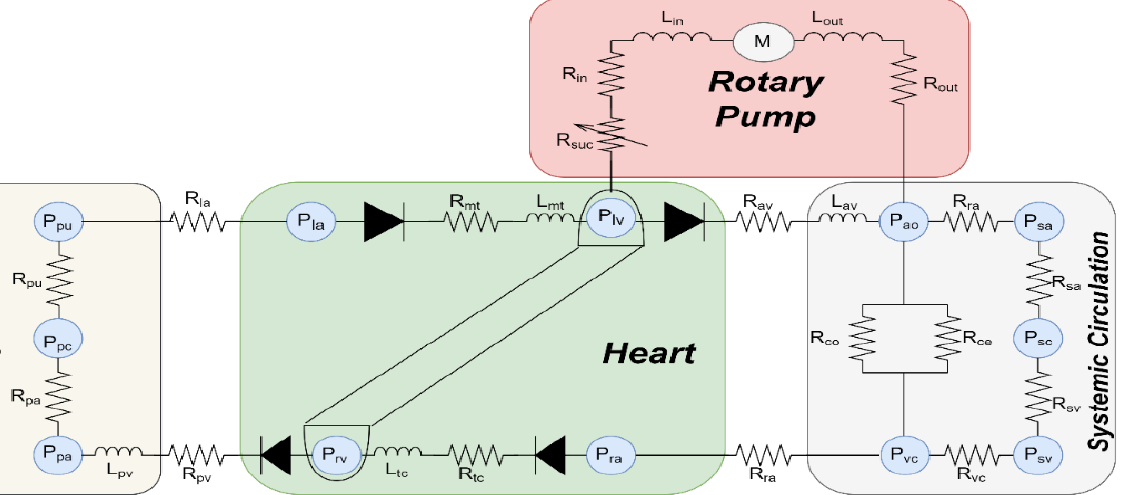
Figure 1. Cardiovascular system CVS-IRBP interaction model. M : pump motor; P : pressure; D : diodes; L : inertances; E : elastances; R : resistances; L in : inlet cannulae inertances; L out : outlet cannulae inertances; R suc : suction resistance; R in : inlet cannulae resistances; R out : outlet cannulae re- sistances.